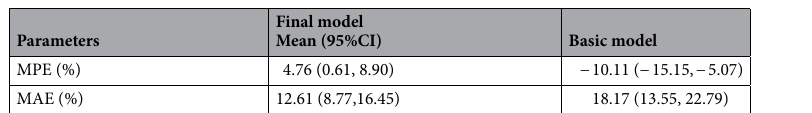
Table 5. External evaluation parameters of the basic model and final model. MPE mean prediction error; MAE mean absolute prediction